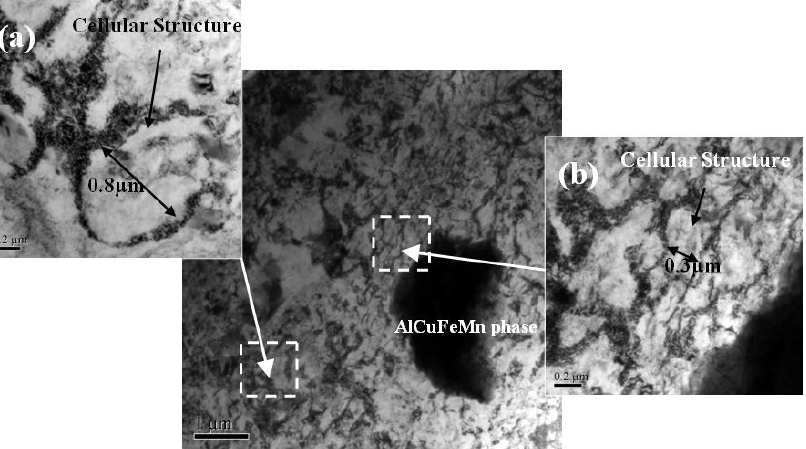
Figure 7. TEM images showing the dislocation distributions around CSPs in the sample after 80% cold rolling: ( a ) the region far from the interface of the particle; ( b ) the region adjacent to the interface of the particle.